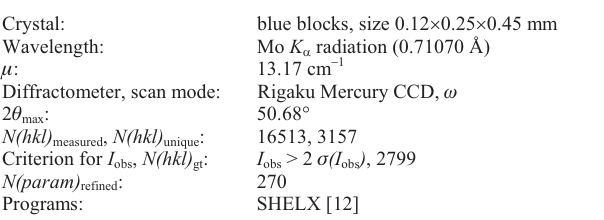
Table 1. Data collection and handling.